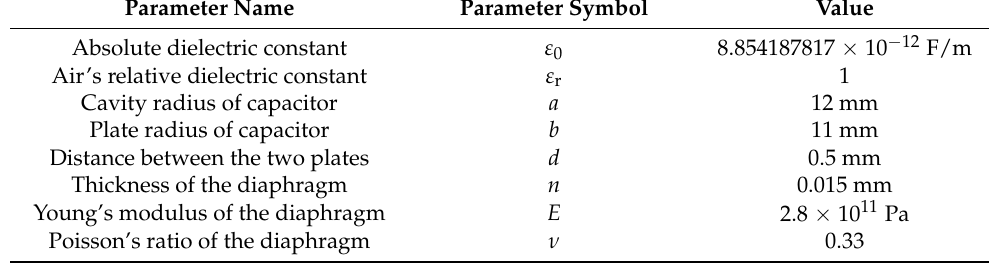
Table 1. Sensor’s structural parameters used for MATLAB calculation and COMSOL simulation.